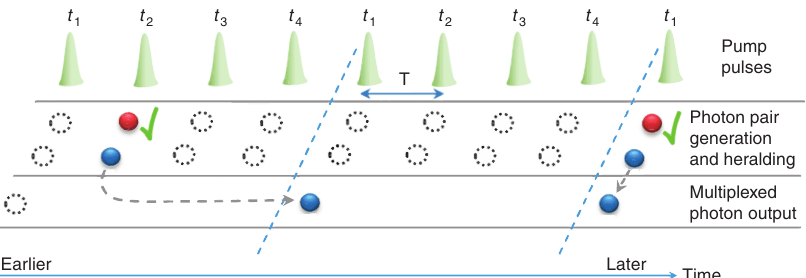
Figure 1 | The principle of active temporal multiplexing. A nonlinear device is pumped by pulses separated in time by period T , each generating correlated photon pairs randomly. The two photons from each pair are spatially separated by frequency (colour) and the heralding photons (red) are detected, indicating the existence of the heralded photons (blue). Depending on the time bin in which a pair is generated, an appropriate delay is applied to the heralded photon so that it always appears in time bin t 1 with a nominal period NT ( N ¼ 4 in this